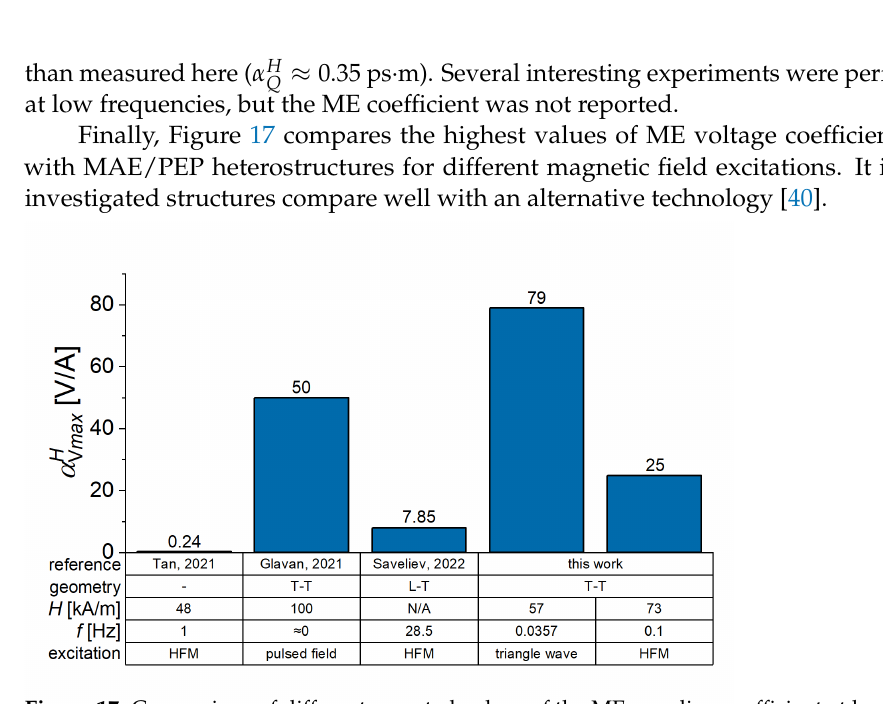
Figure 17. Comparison of different reported values of the ME coupling coefficient at low frequencies. (N/A stands for not available; Tan, 2021 stands for [40]; Glavan, 2021 stands for [24] and Saveliev, 2022 stands for